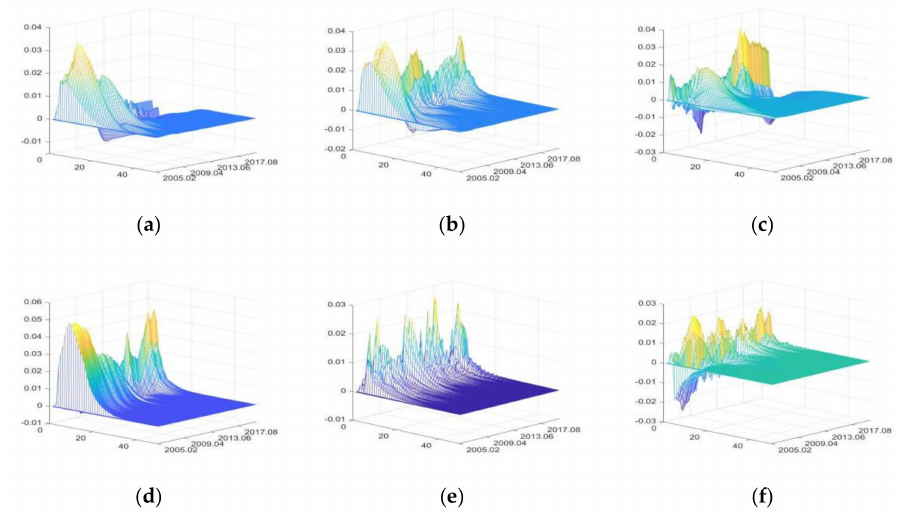
Figure 15. The three-dimensional impulse responses of FCP to positive shocks of external uncer- tainties. ( a ) Shocks of IRU. ( b ) Shocks of FU. ( c ) Shocks of SDU. ( d ) Shocks of CU. ( e ) Shocks of DE. ( f ) Shocks of